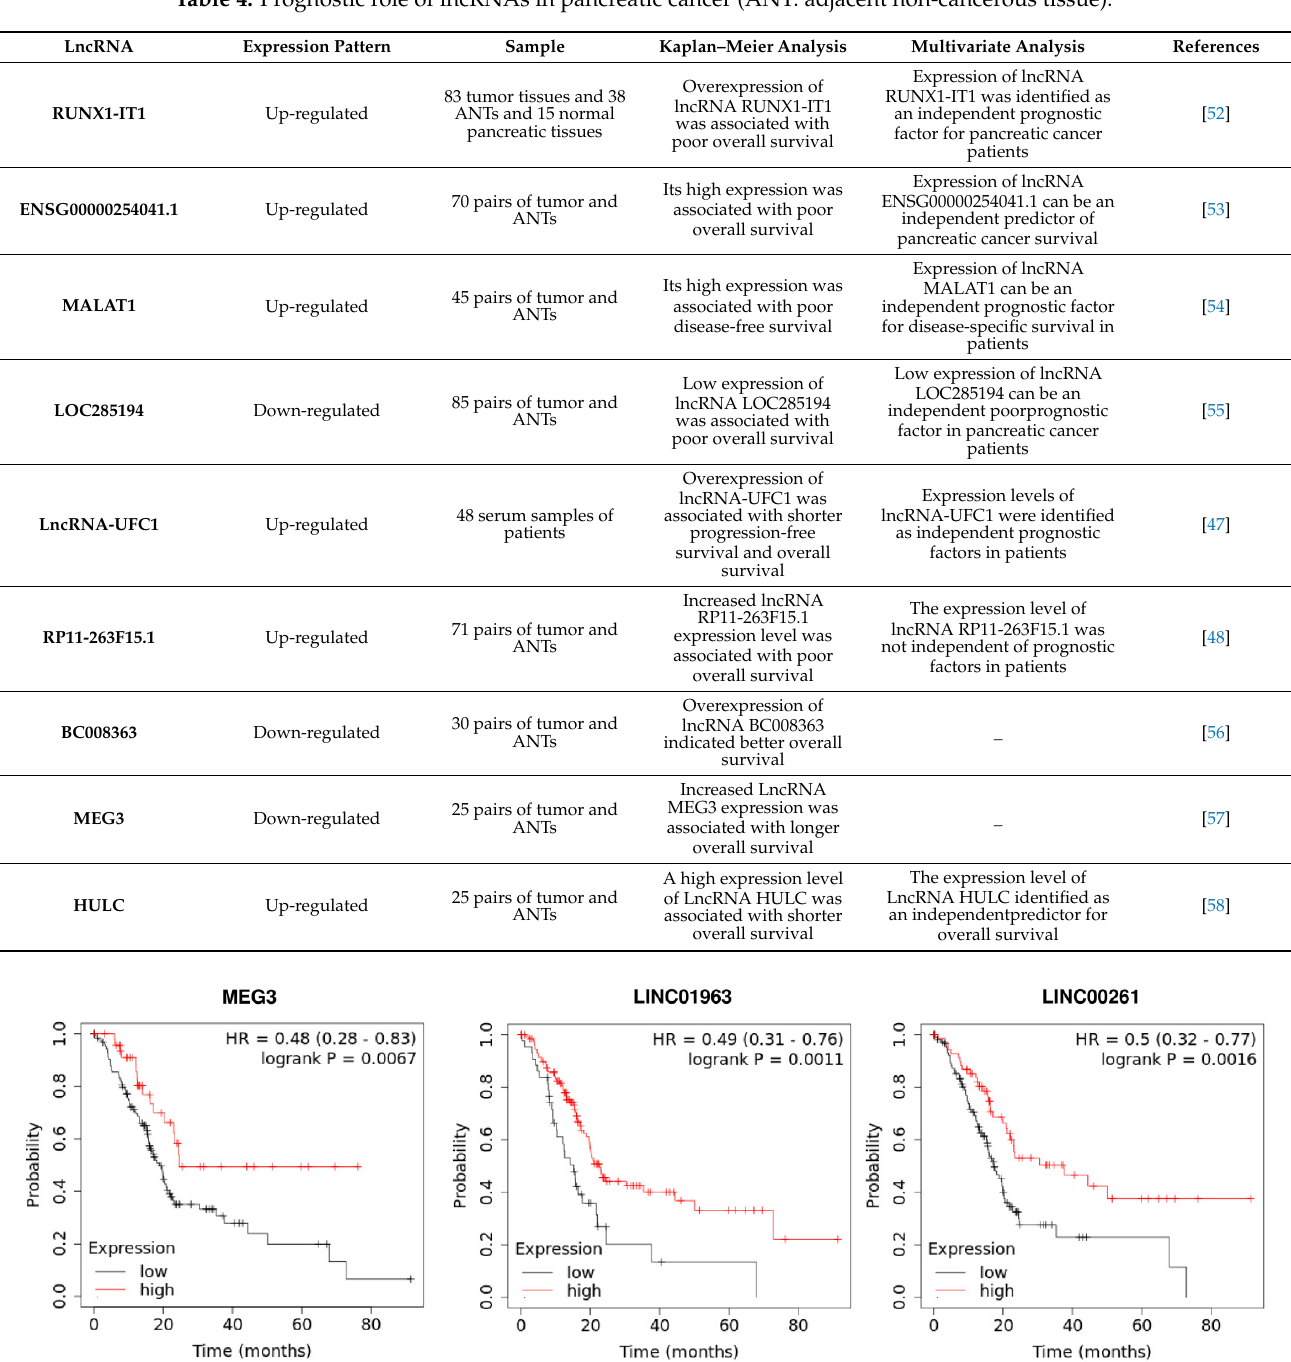
Figure 3. The prognostic value of lncRNA MEG3, LINC01963, and LINC00261 in pancreatic cancer patients was analyzed using the KM-plotter database.